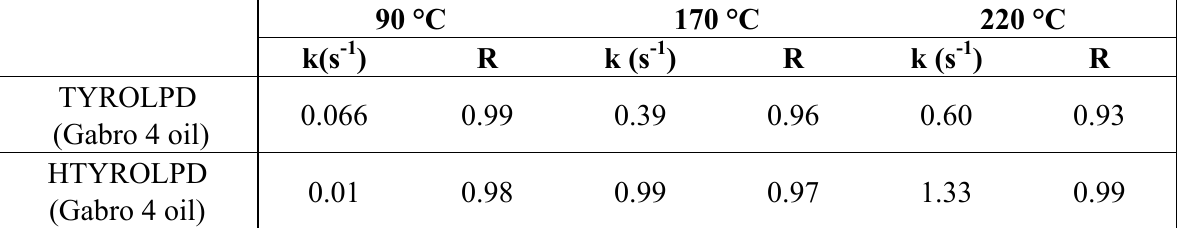
Table 2. The reaction rate constants (k) for Tyr-OLPD and